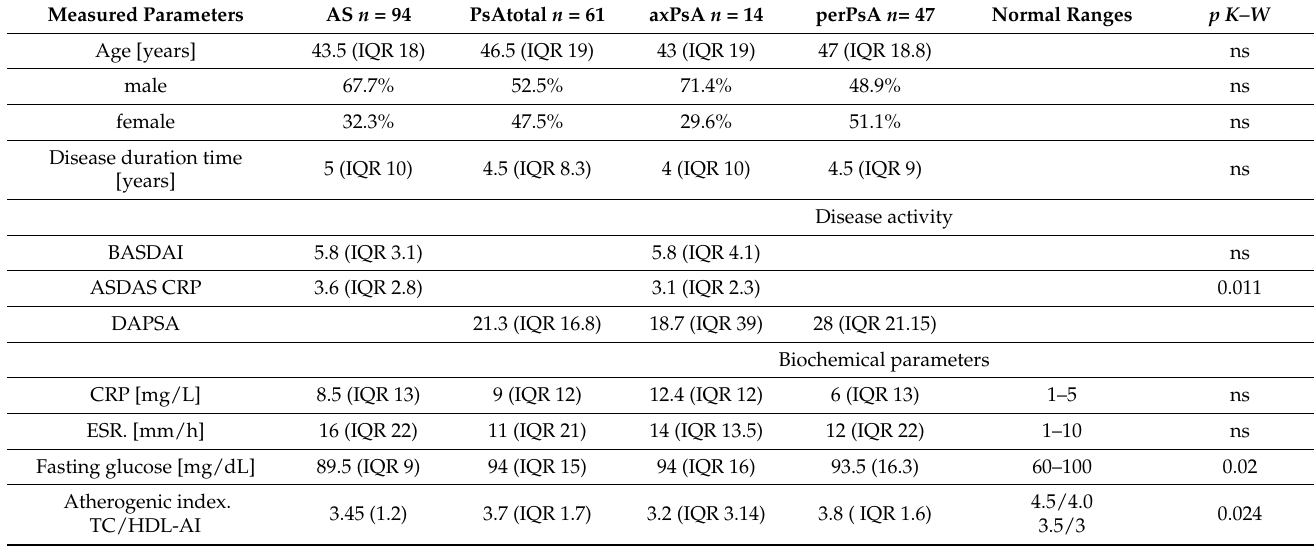
Table 1. Demographic and clinical characteristics of AS and PsA